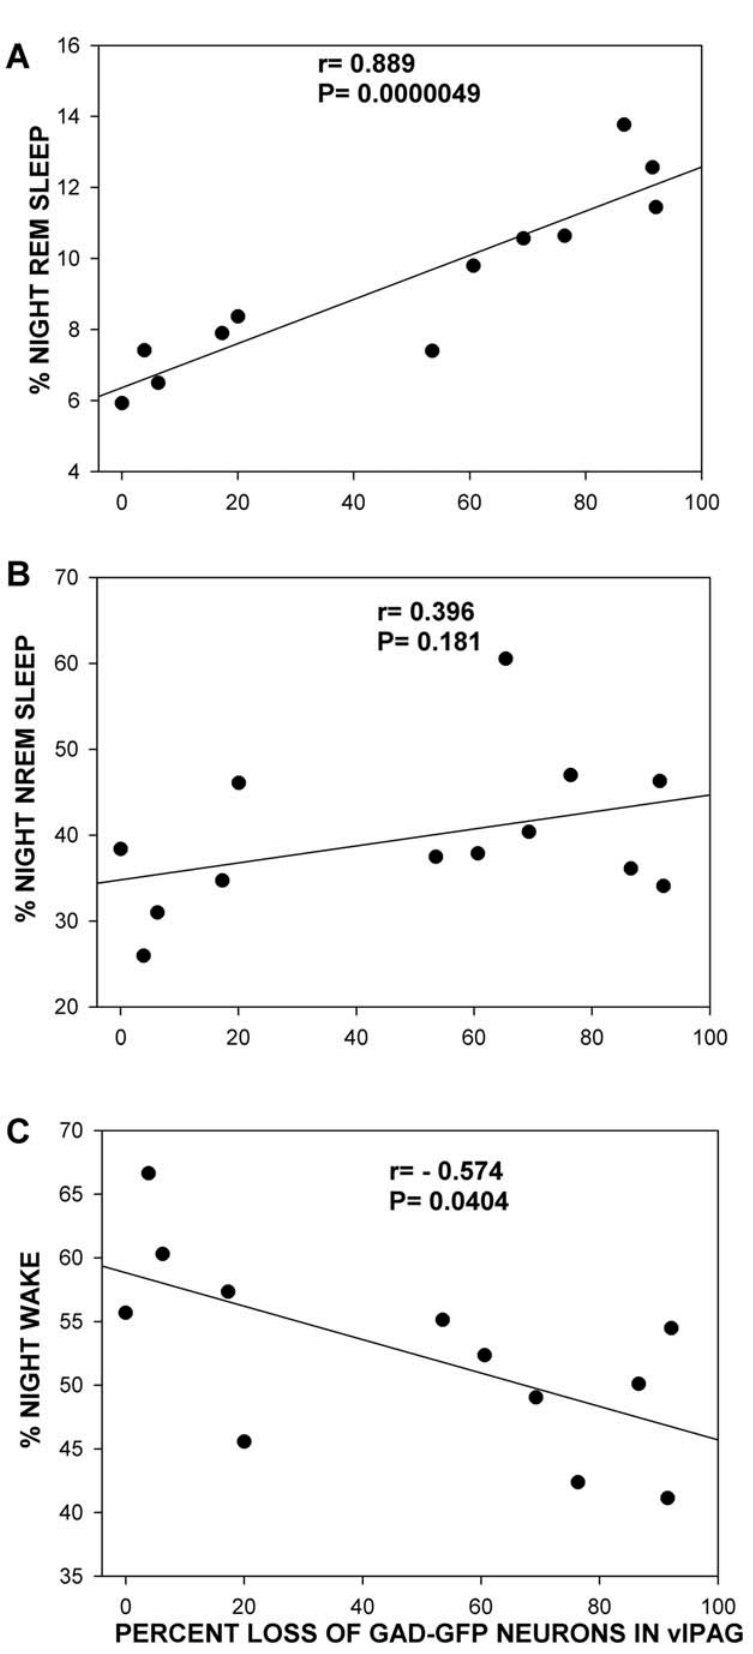
Figure 11. Relationship between loss of GFP neurons in the vl PAG and sleep-wake states.